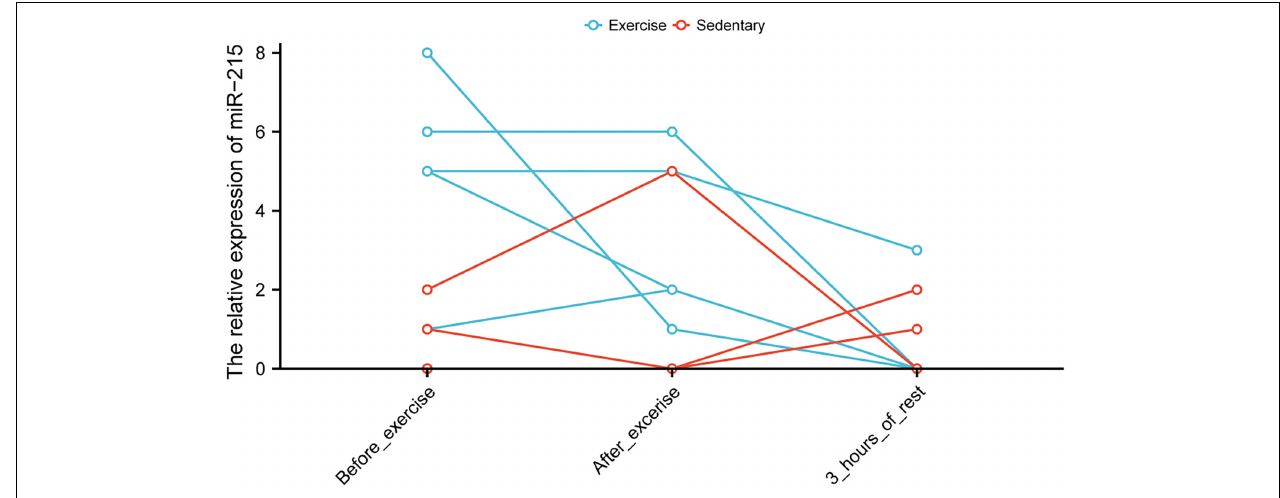
FIGURE 7 | Altered levels of miR-215 in circulating blood exosomes before and after